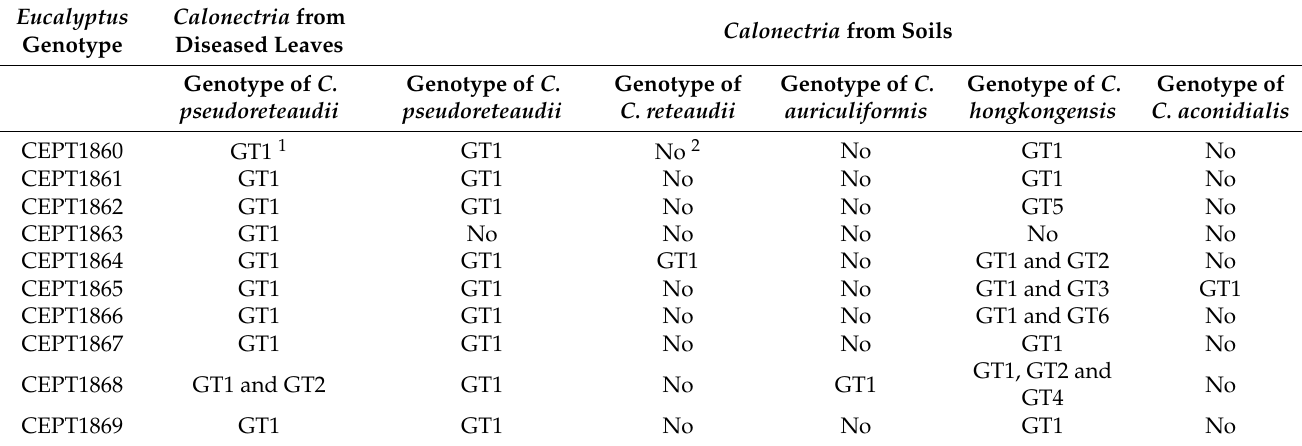
Table 4. Species and genetic diversity of Calonectria associated with Eucalyptus genotype and substrate.